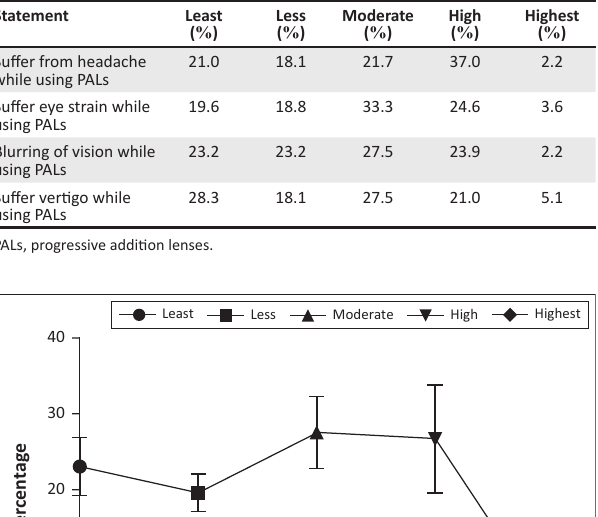
TABLE 3: Respondent complaints associated with progressive addition lenses.